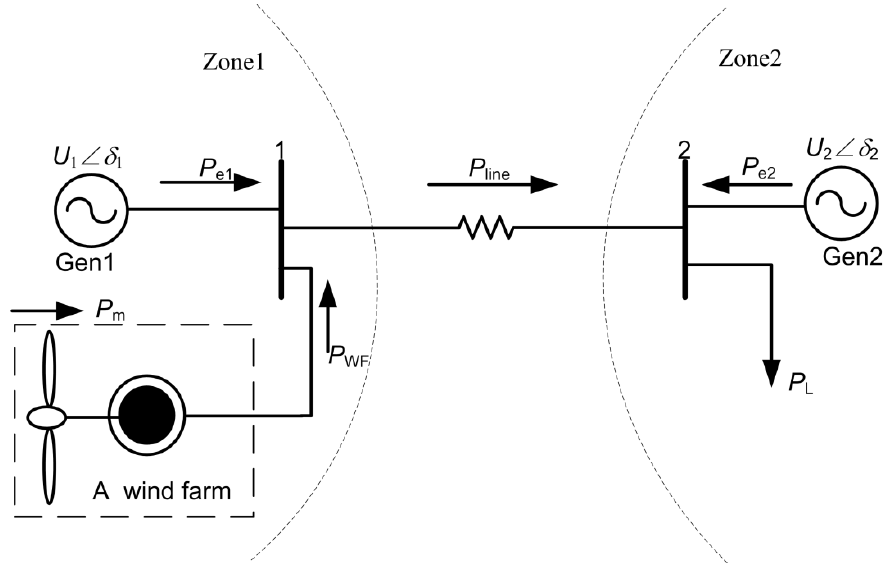
Figure 2. A two-machine system with a wind